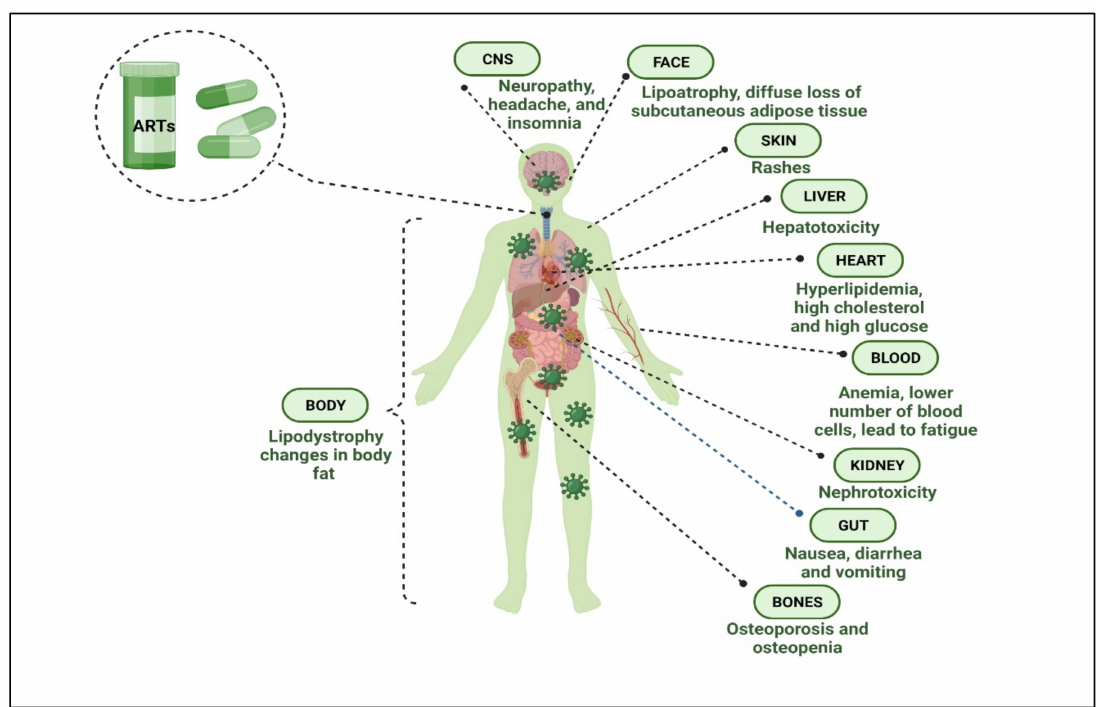
Figure 4. The illustration shows the major side effects of antiretroviral drugs on different body sites in an HIV/AIDS individual. (Created with BioRender.com (access on 19 June